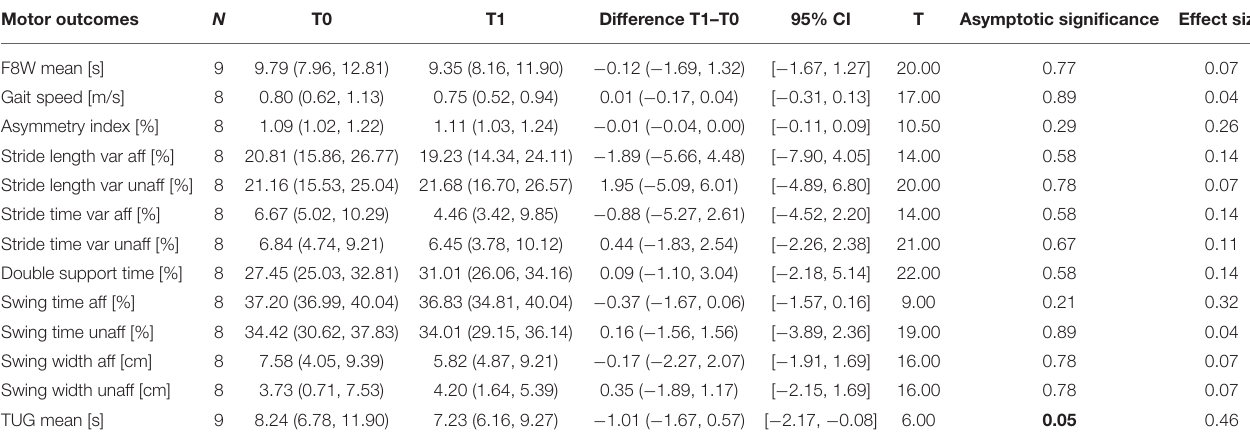
TABLE 4 | Results secondary motor outcomes.